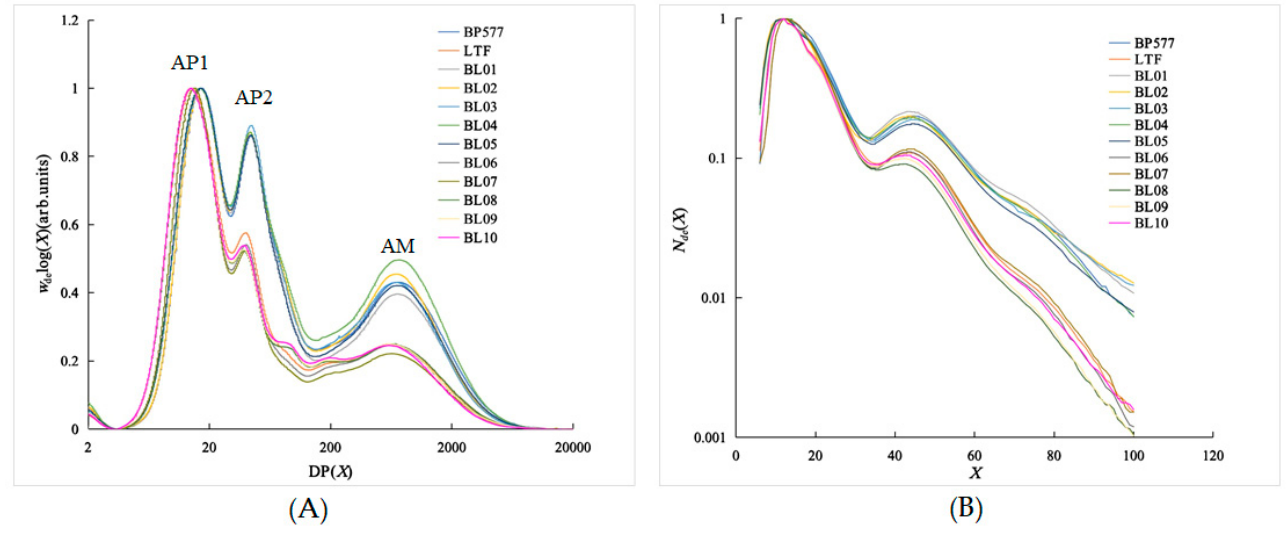
Figure 2. The chain length distribution (CLD) of debranched starch. ( A ): SEC weight CLDs of the whole range of debranched starch; ( B ): FACE number CLDs of debranched amylopectin branches. All distributions are normalized to the global maximum peak.